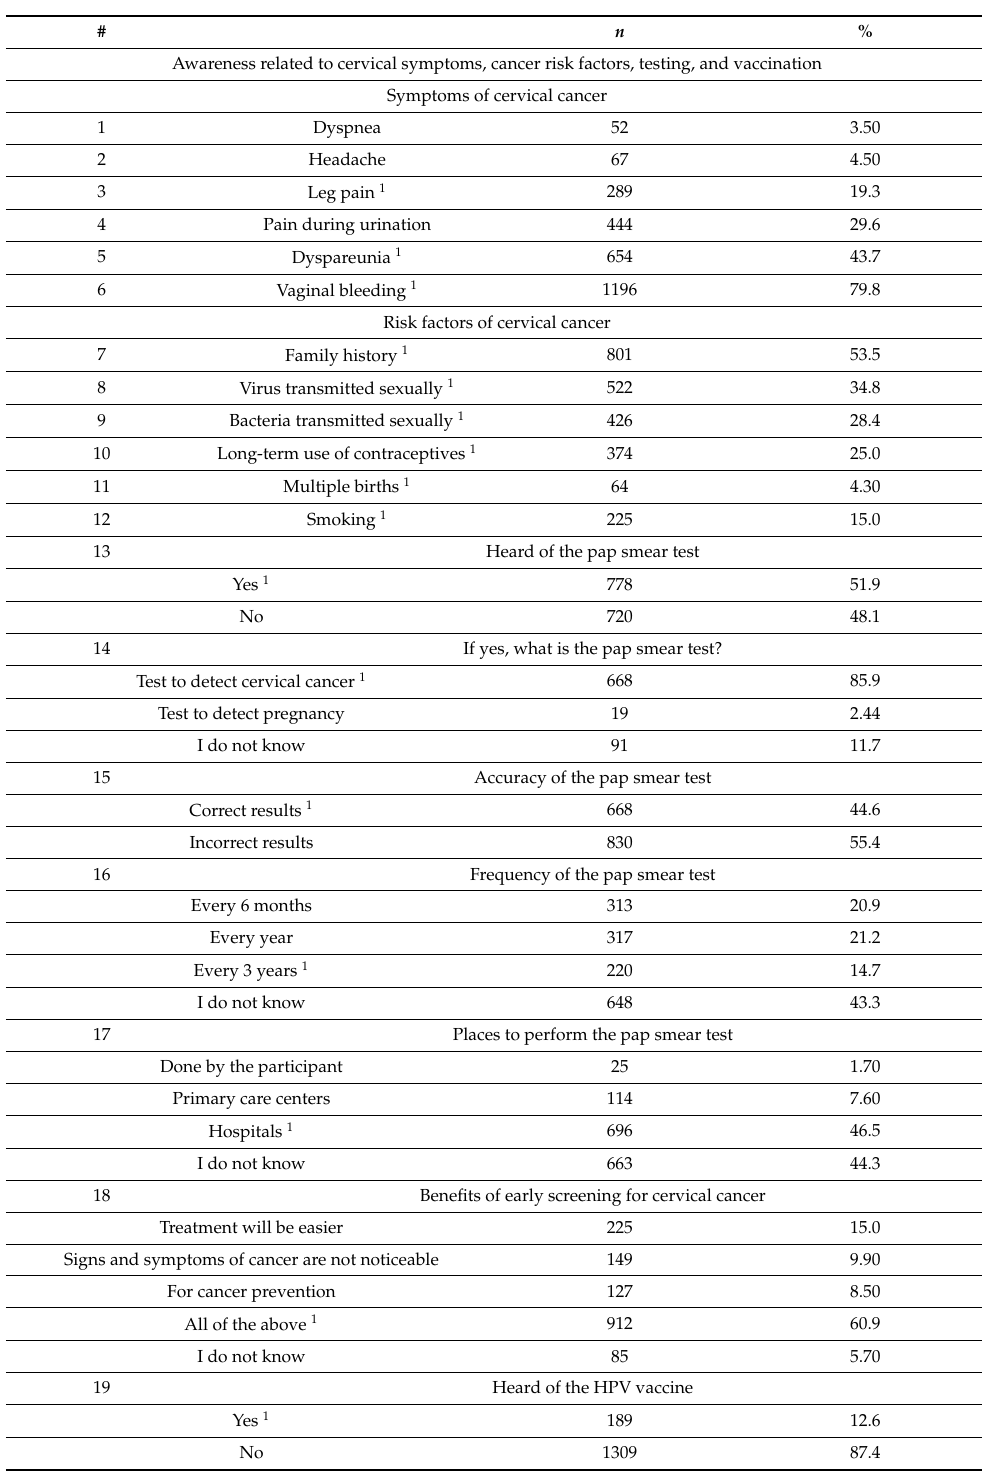
Table 2. Awareness and practices related to cervical cancer ( n =